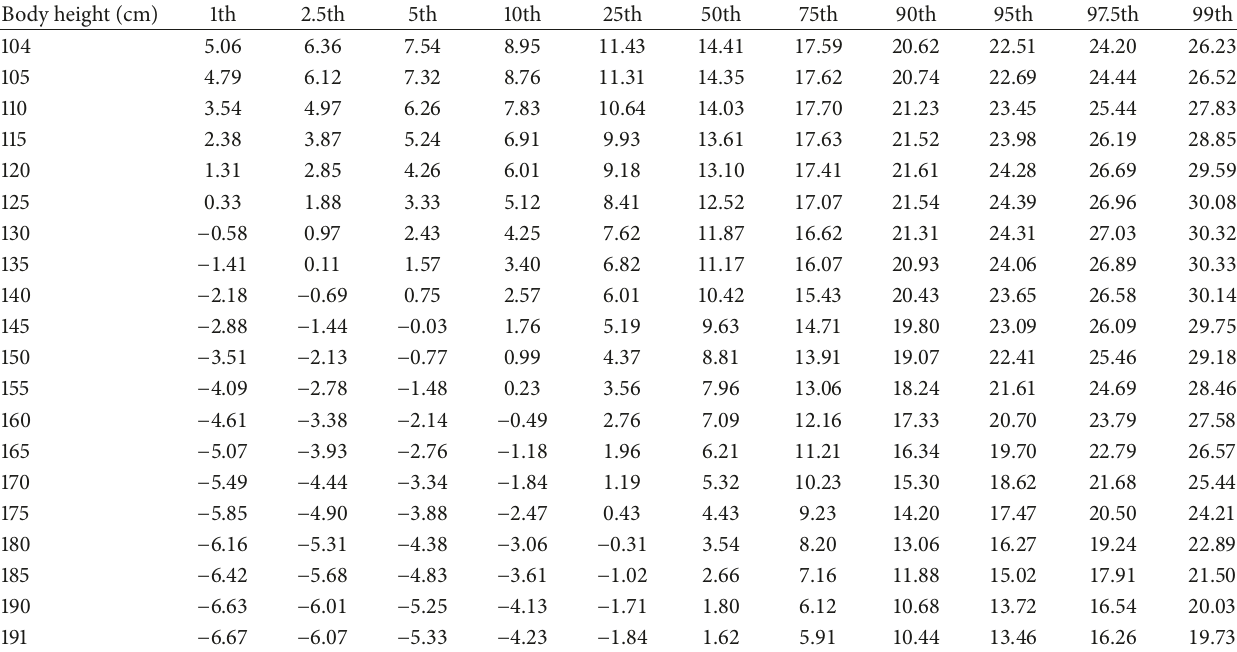
Table 10: Body height-related reference intervals (RIs) for central (aortic) augmentation index (cAIx) for males ( 𝑛 = 576 ).